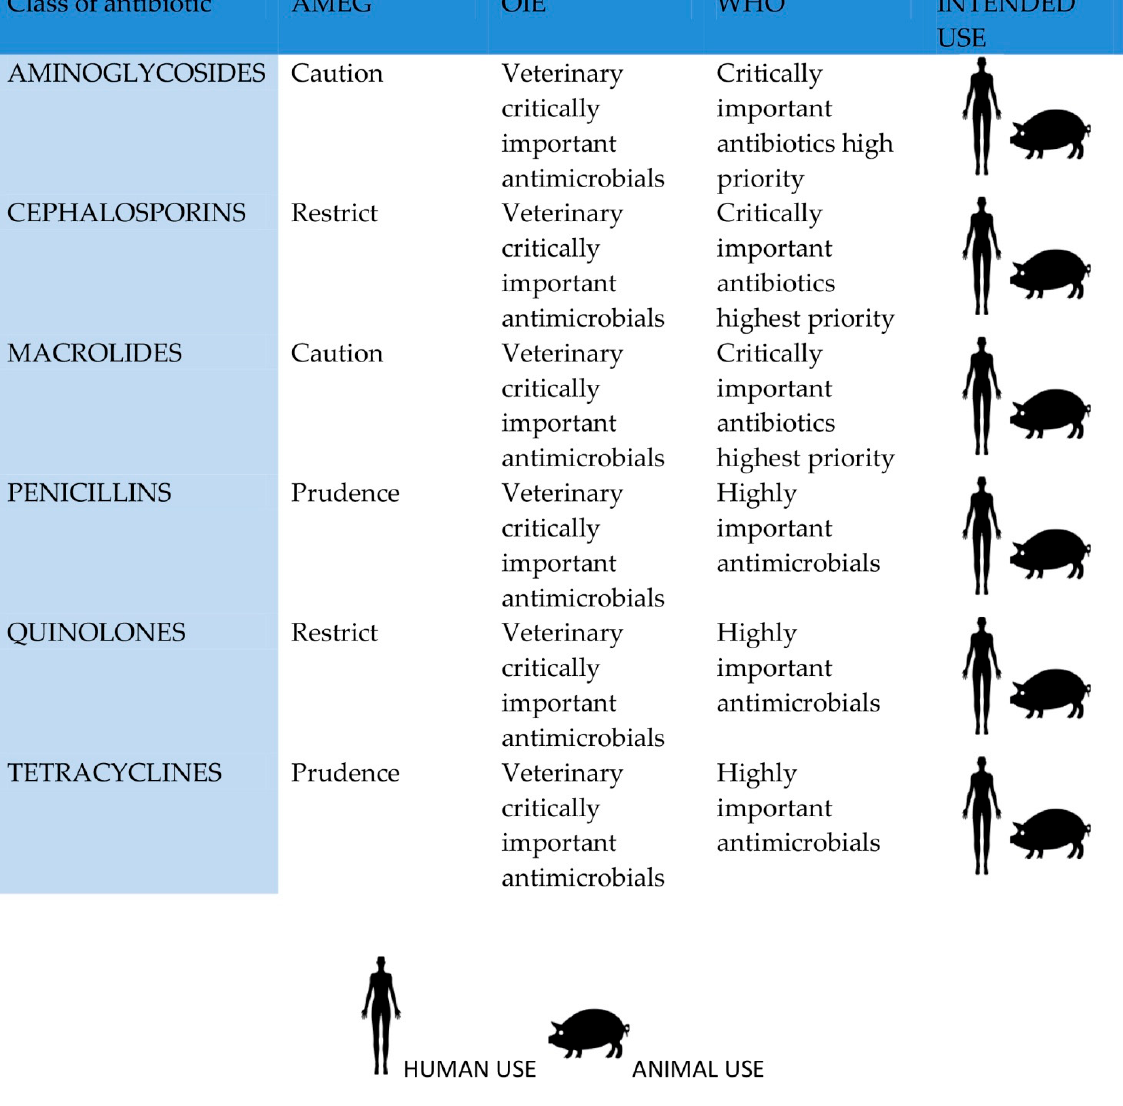
Figure 1. Comparison listing of CIAs by WHO (2019), OIE (2018), and AMEG—EMA (2019) for the major classes of antibiotics adapted from [134].